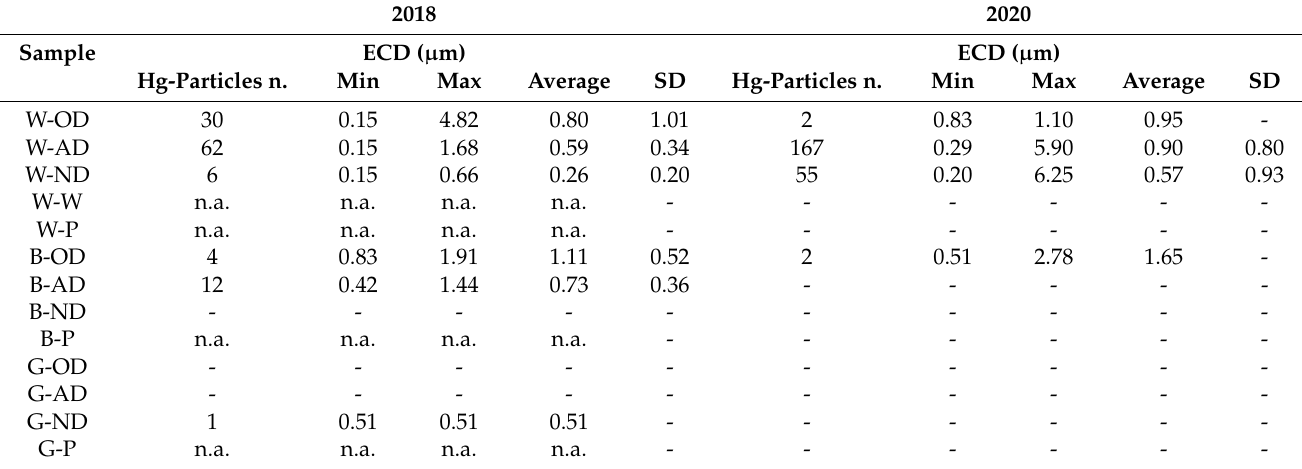
Figure 3. ( a ) Frequency distribution and ( b ) cumulative percentage of equivalent circular diameter (ECD) of all the Hg-particles in both the 2018 and 2020 sampling campaigns; ( c ) particle size ranges divided by year and dust type. Table 2. Results of the dimensional analysis of particulate bound mercury (PBM); for samples names, refer to Table